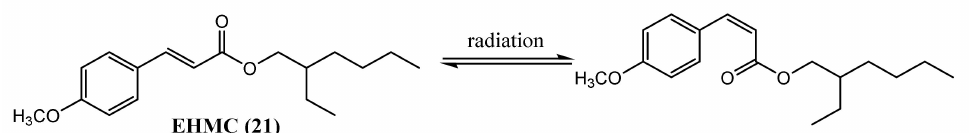
Figure 3. Interconversion between E and Z isomers when EHMC ( 21 ) is exposed to UV